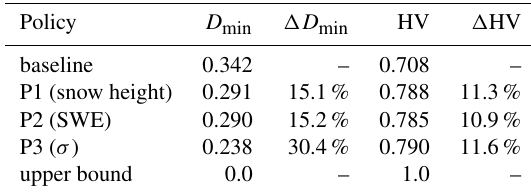
Table 1. Operational value of the VSIs quantified by the two metrics introduced in Sect.